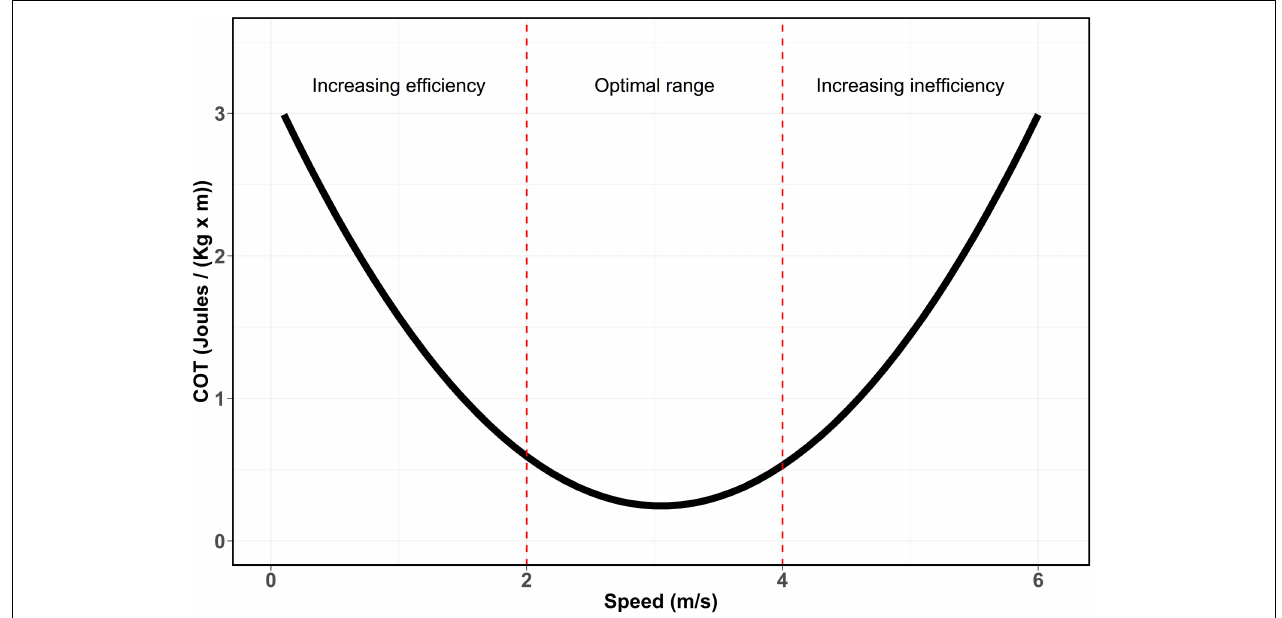
FIGURE 2 | U-shaped curve (Schmidt-Nielsen, 1972) showing the relationship between speed and cost of transport based on energetic efficiency. Red dashed lines represent the theoretic division of the curve based on metabolic efficiency. Increasing swimming speed, increase the energetic efficiency by reducing the COT. This reduction continues until the optimal range of transport, where the maximum efficiency and minimum COT are reached. Finally, when speeds continue to increase, COT increases rapidly leading to an increasing energetic inefficiency.